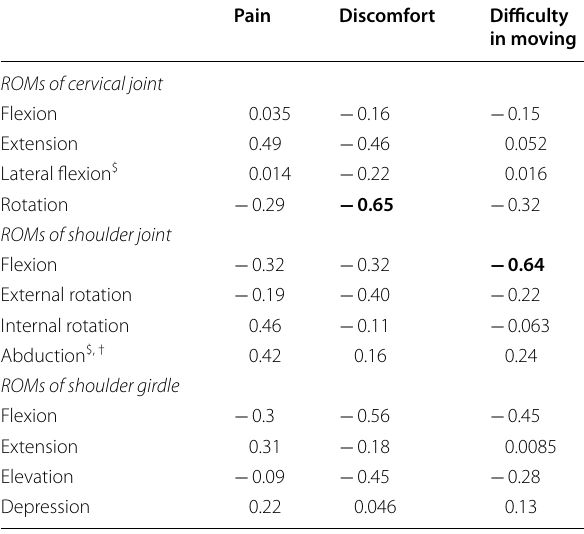
Table 3 The correlation coefficients ( r ) between changes in subjective measure and range of motion